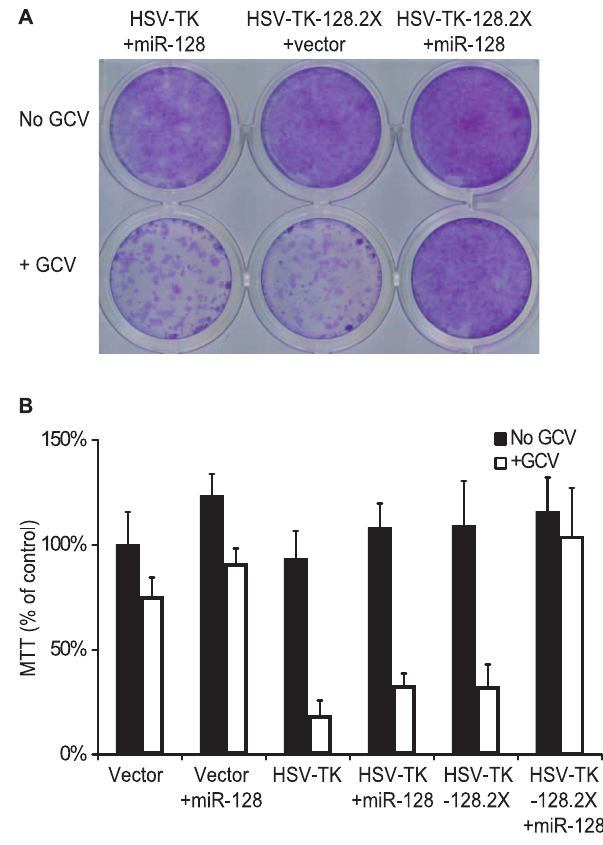
Figure 3. MiRNA regulation of HSV-TK in U373 glioblastoma cells. A. Crystal violet staining of U373 glioblastoma cells expressing HSV-TK or HSV-TK-128.2X following GCV treatment. pcDNA3-HSV-TK- 128.2X contains two perfect binding sites for miR-128 in the 3 9 UTR of HSV-TK. Cells were co-transfected with either pcDNA3 ( + vector) or pcDNA3-miR-128 ( + miR-128) and subjected to 10 m g/mL ganciclovir selection ( + GCV) for 10 days prior to staining. B. miR-128 rescues HSV- TK-128.2X expressing U373 cells from GCV-induced cell death. U373 cells were co-transfected with pcDNA3 (vector), pcDNA3-HSV-TK, or pcDNA3-HSV-TK-128.2X and either pcDNA3 as control or pcDNA3-miR- 128 ( + miR-128). Cells were plated in 24-well plates with media containing 10 m g/ml GCV and cell viability was measured at 10 days by MTT assay as described in Methods (n=3). Absorbance values are normalized to control cells (transfected with empty vector and grown in media without GCV). number of brain-specific miRNAs [42,43]. We treated two neuroblastoma cell lines with 10 m M ATRA for five days and assayed cellular miRNA expression by primer extension (Fig. 5A). Three glioblastoma cell lines were also treated with ATRA as controls. Congruent with previous studies [42,43], ATRA treatment of SH-SY5Y cells induced expression of the brain- enriched miRNAs miR-128 and miR-124 (Fig. 5A) as well as miR- 132 and miR-7 (not shown).